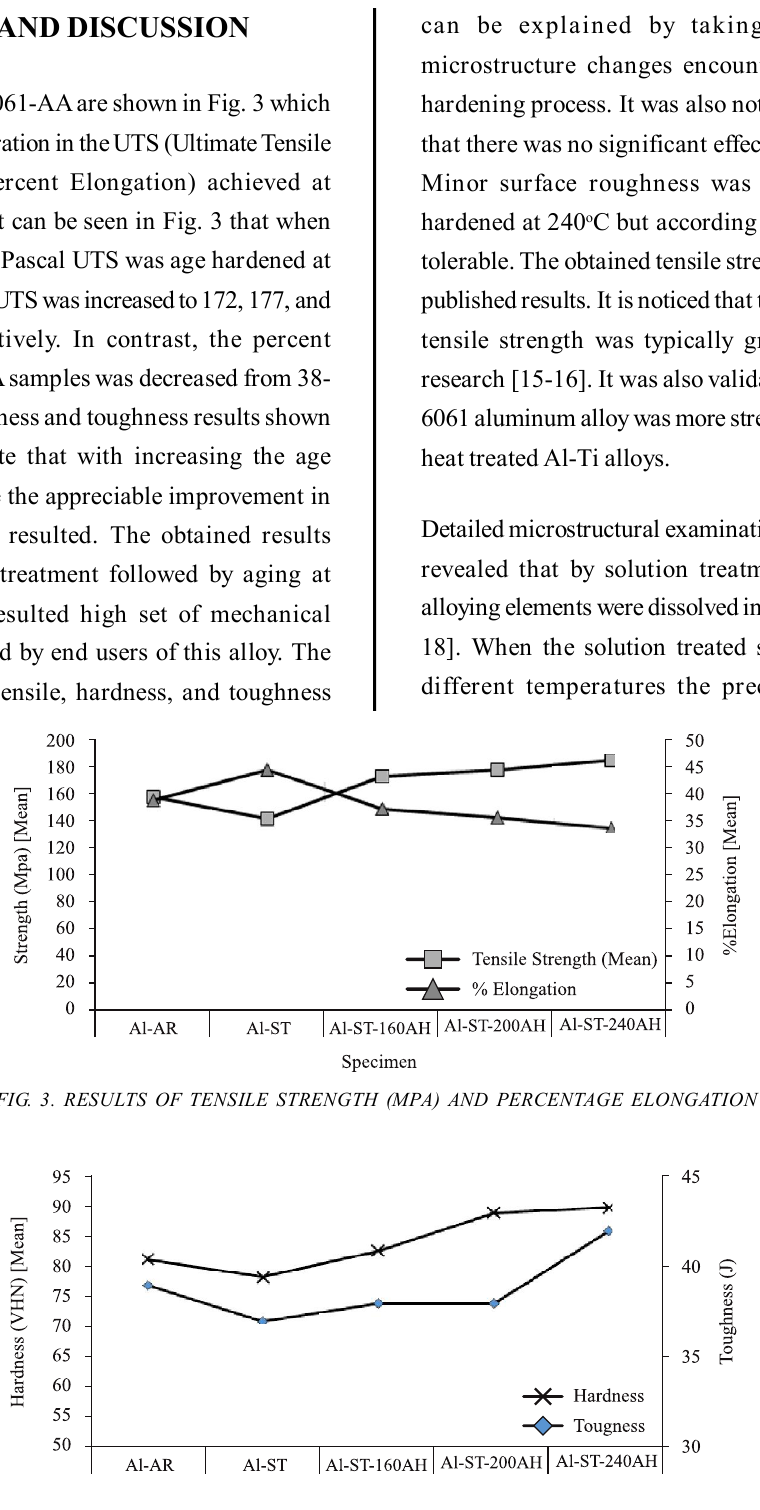
FIG. 4. RESULTS OF TOUGHNESS AND